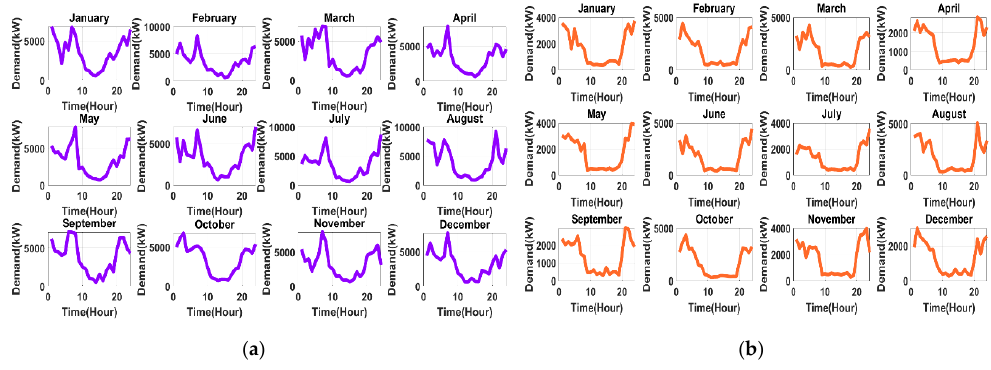
Figure 16. Daily peak demand shift of ( a ) electric load; ( b ) thermal load.